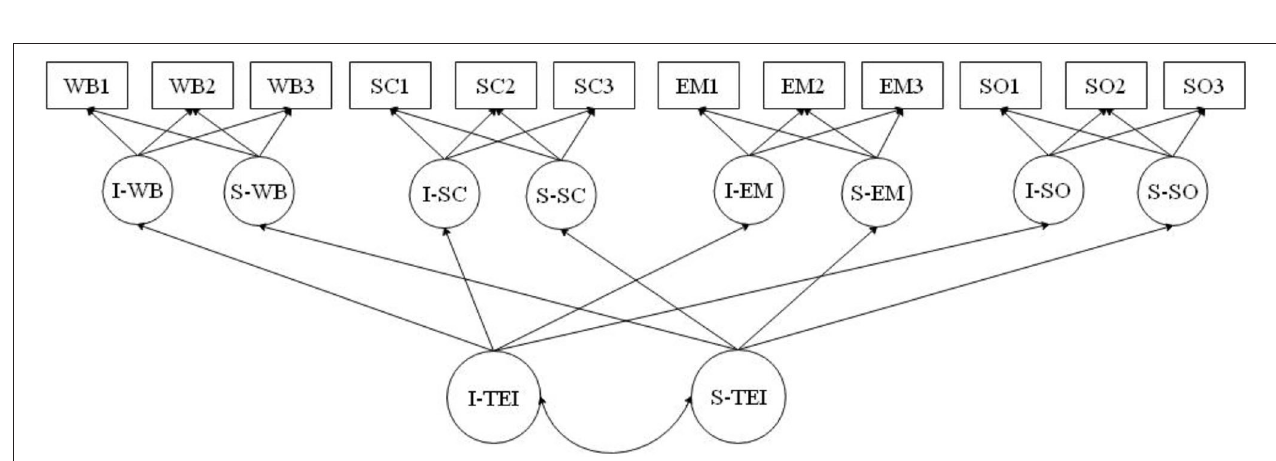
FIGURE 2 | Factor-of-curves model (FCM), a second-order LGM. I, intercept; S, slope; TEI, trait emotional intelligence; WB, well-being; SC, self-control; EM, emotionality; SO,